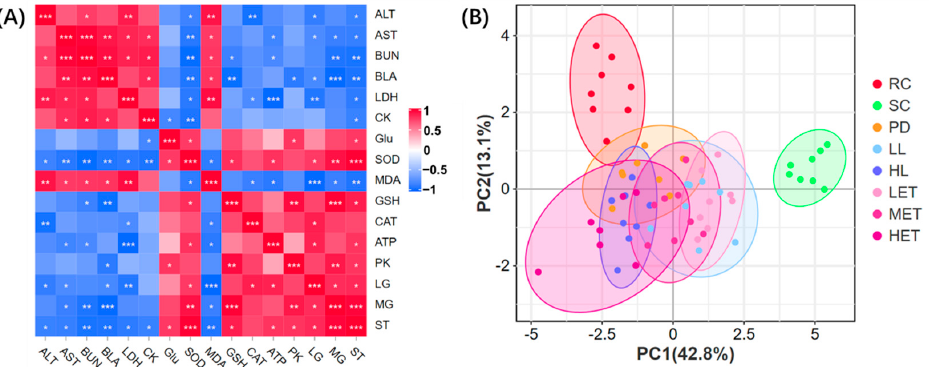
Figure 8. Biochemical parameters correlation analysis and PCA analysis. ( A ) Correlation analysis, ( B ) PCA analysis. N = 8, *: p < 0.05, **: p < 0.01, ***: p < 0.001. The confidence level of the confidence ellipse in the PCA analysis is 95%.